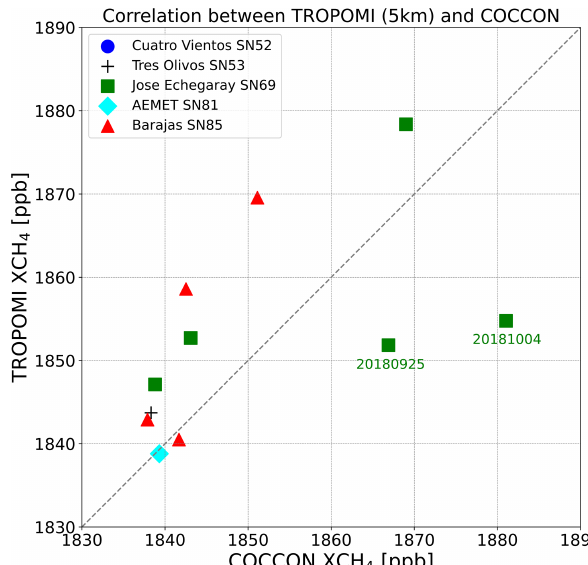
Figure 3. Correlation plot between TROPOMI observations col- lected within 5km radius around each COCCON station and co- incident COCCON measurements (30min before and after the TROPOMI overpass) at five stations in